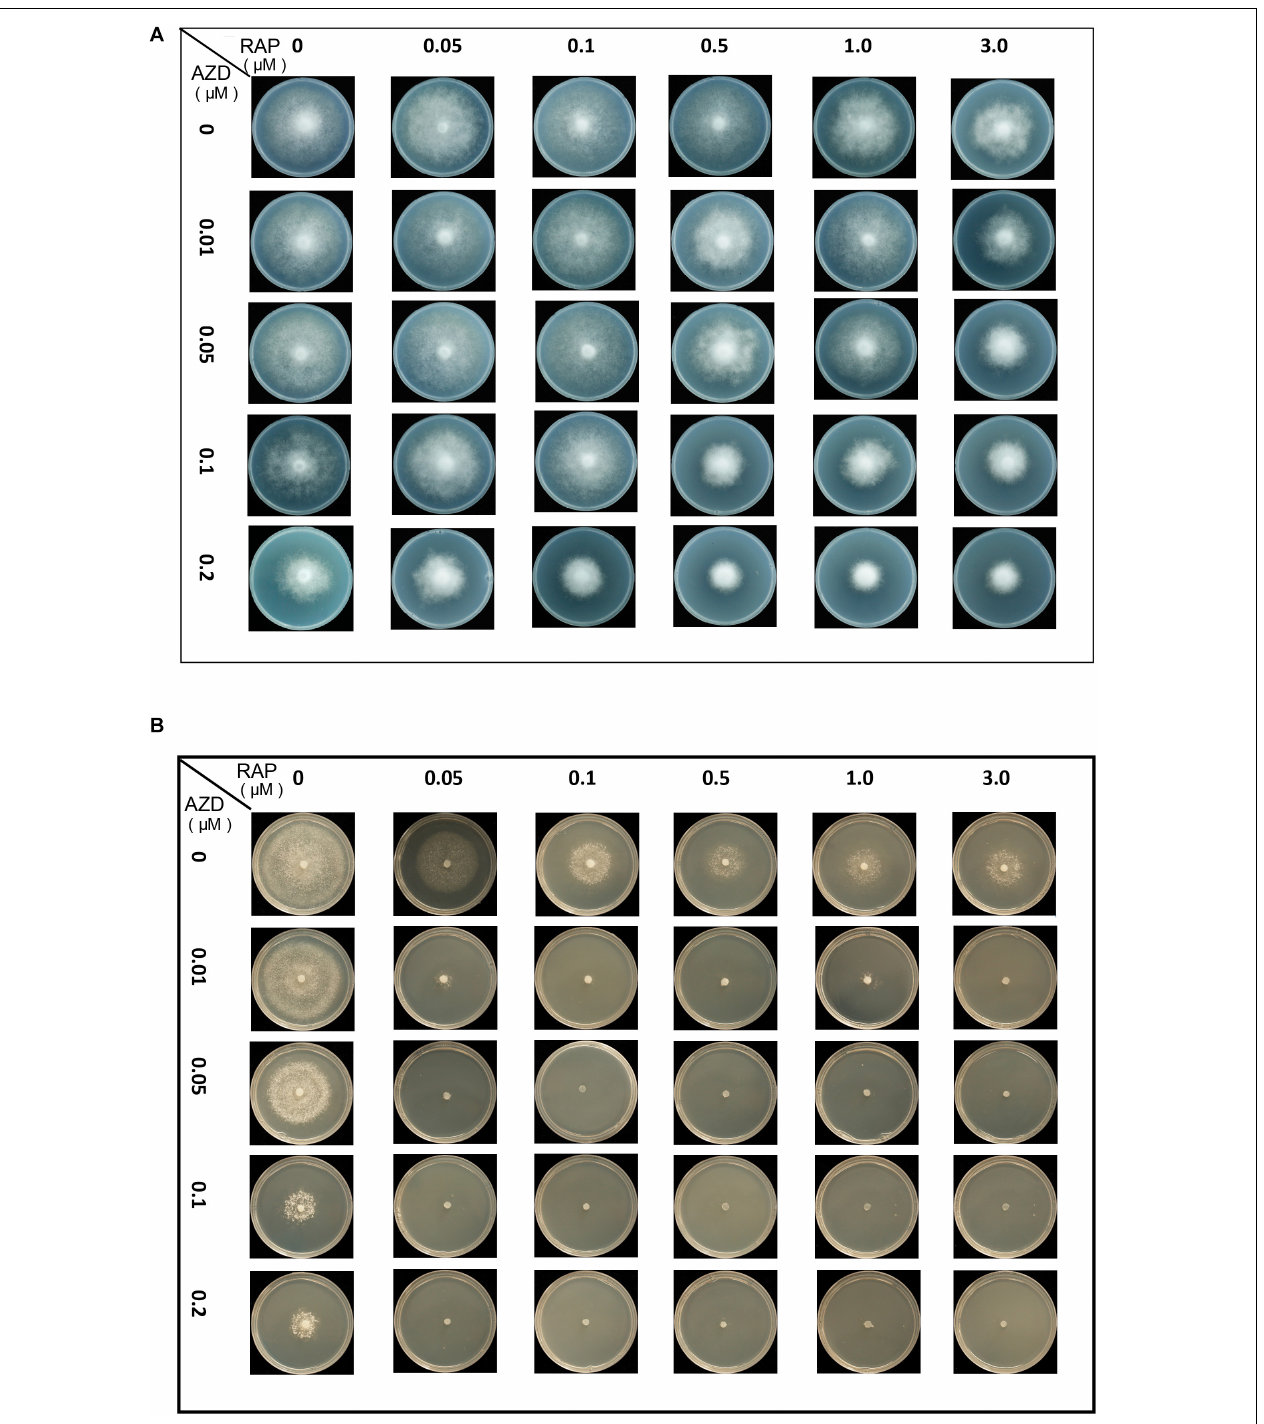
FIGURE 3 | Synergistic growth inhibition of P. infestans treated by co-application with RAP and AZD. Colony morphology of (A) T30-4 and (B) 002 treated by co-application with RAP and AZD.